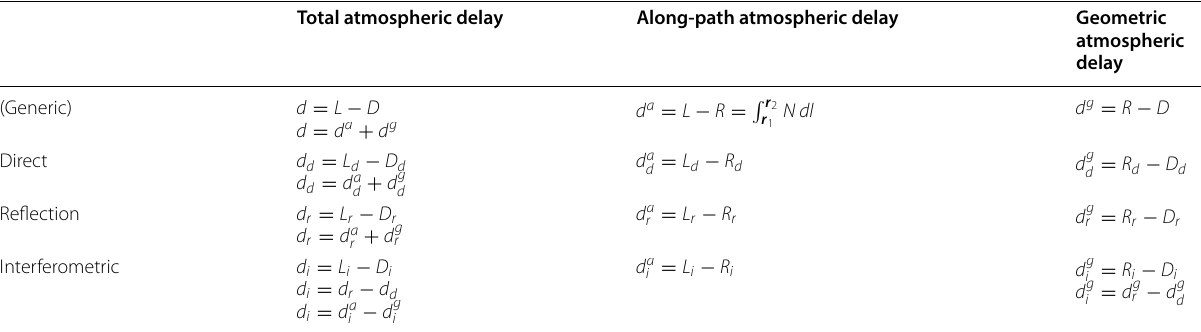
Table 2 Definition of atmospheric delay and its components Total atmospheric delay